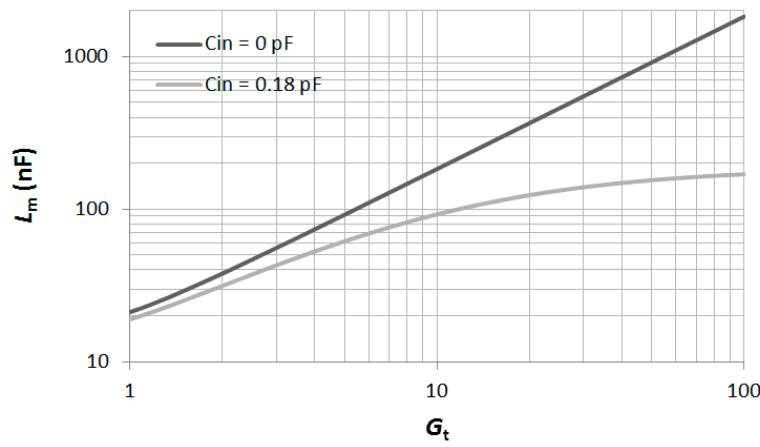
Figure A2. L m values in function of G t for C in = 0 pF and C in = 0.18 pF .